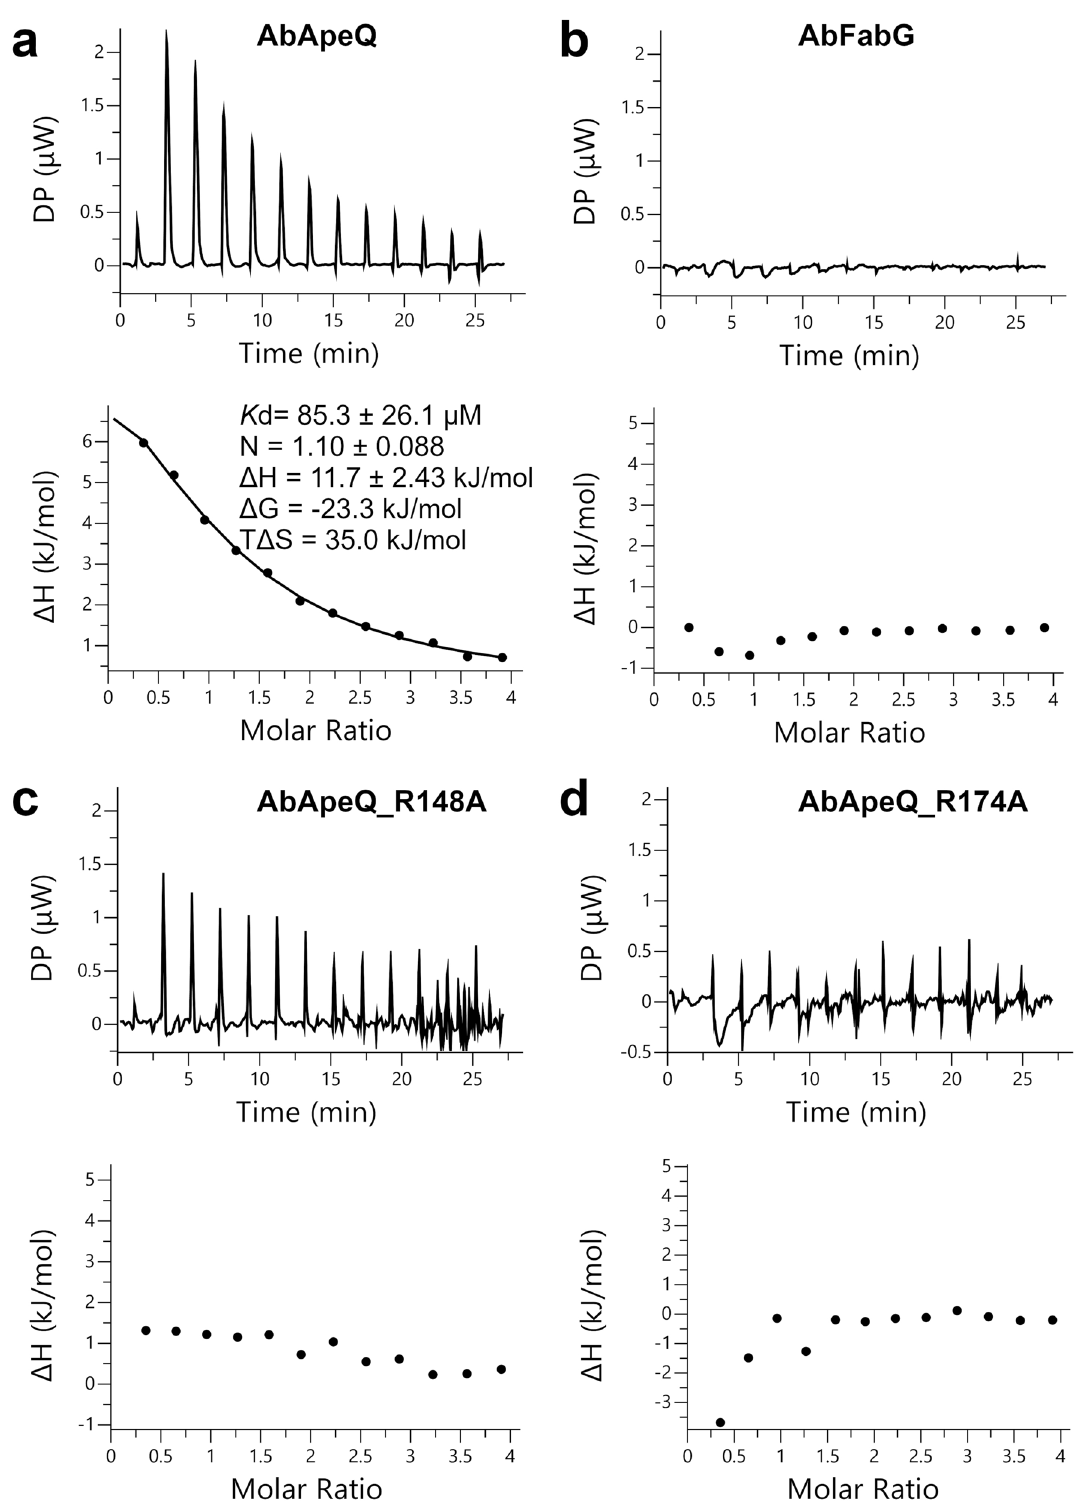
Figure 6. Isothermal titration of AbFabG and AbApeQ or its variants by holo ACP1. ( a ) AbApeQ, ( b ) AbFabG, ( c ) AbApeQ R148A mutant, ( d ) AbApeQ R174A mutant. Upper panels show raw data of heat changes during titration. Lower panels exhibit integrated heat changes. Only the titration of AbApeQ could be fitted with a model, for which the calculated K d is also